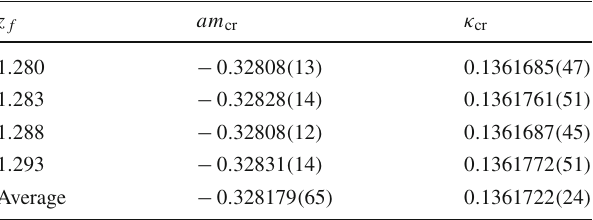
Table 2 Results for am cr ( g 0 , L / a ) for four different values of z f , for L / a = 8 and β = 5 . 3. The weighted average of the results is also given in the last row of the